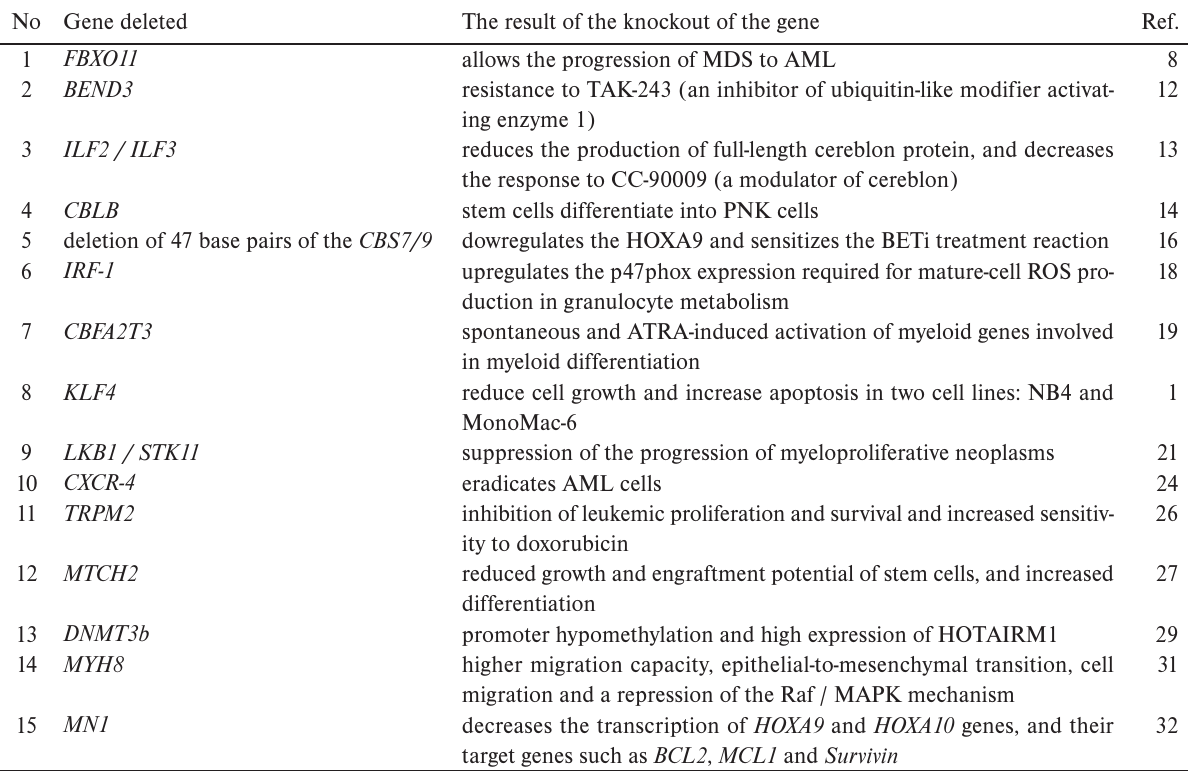
Table 1. The effects of gene deletion obtained by CRISPR/Cas9 technology on AML cell